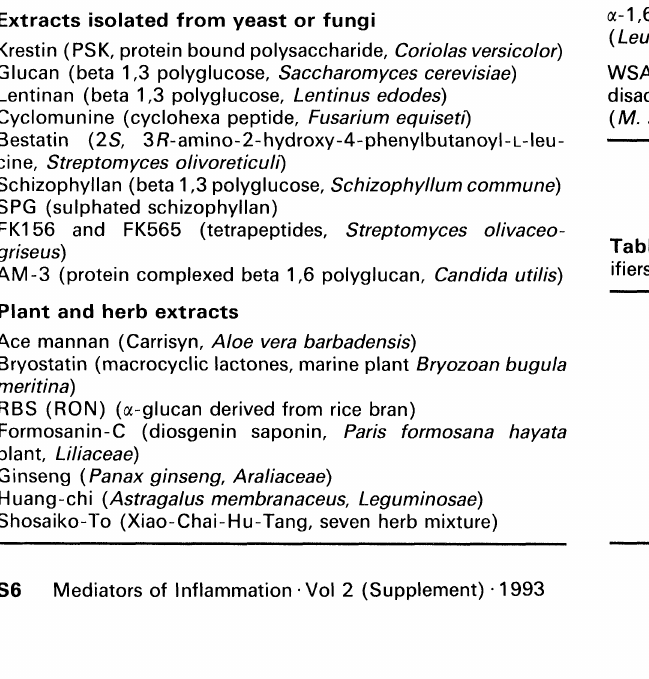
Table 4. Extracts from yeast, fungi, plants and herbs Extracts isolated from yeast or fungi